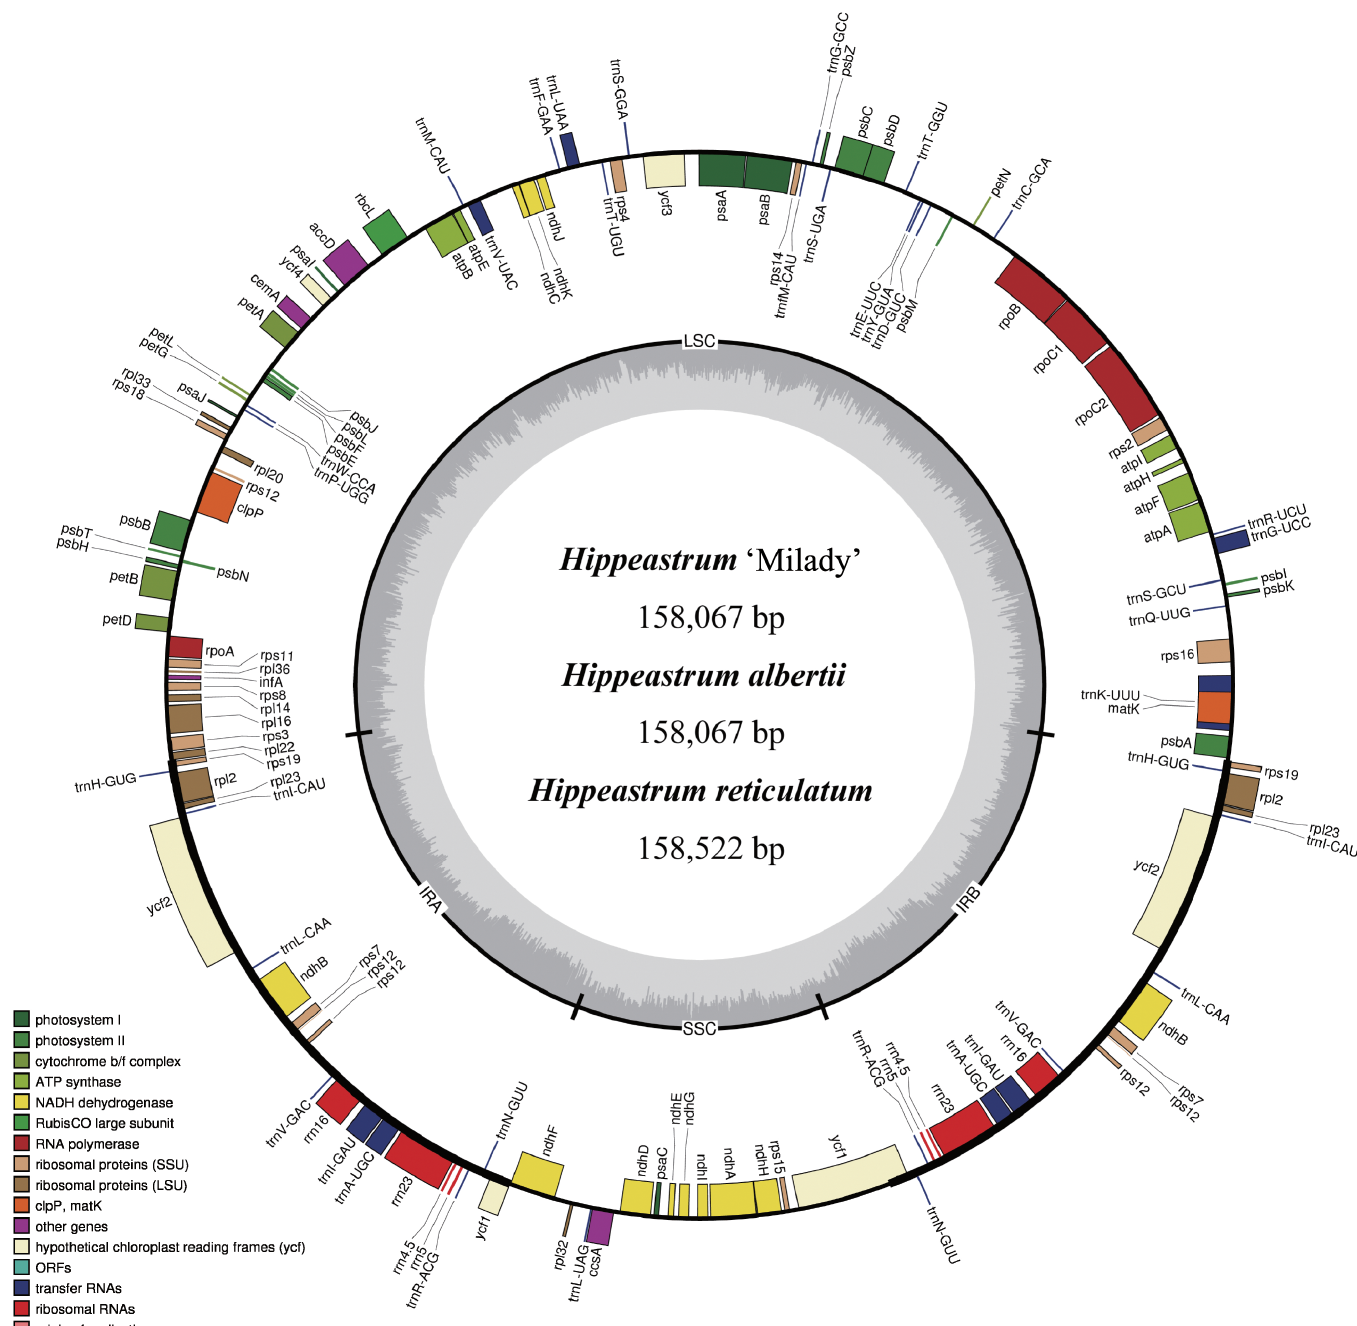
Fig 1. Gene maps of Hippeastrum ‘Milady’, H . alberti , and H . reticulatum . Genes lying outside the circle are transcribed in a clockwise direction, whereas genes on the inside are transcribed in a counterclockwise direction. Different colors denote known functional groups. The relative GC and AT contents of genomic regions are respectively represented in the inner circle by dark and light gray. LSC, SSC, and IR indicate large single copy, small single copy, and inverted repeat regions, respectively.